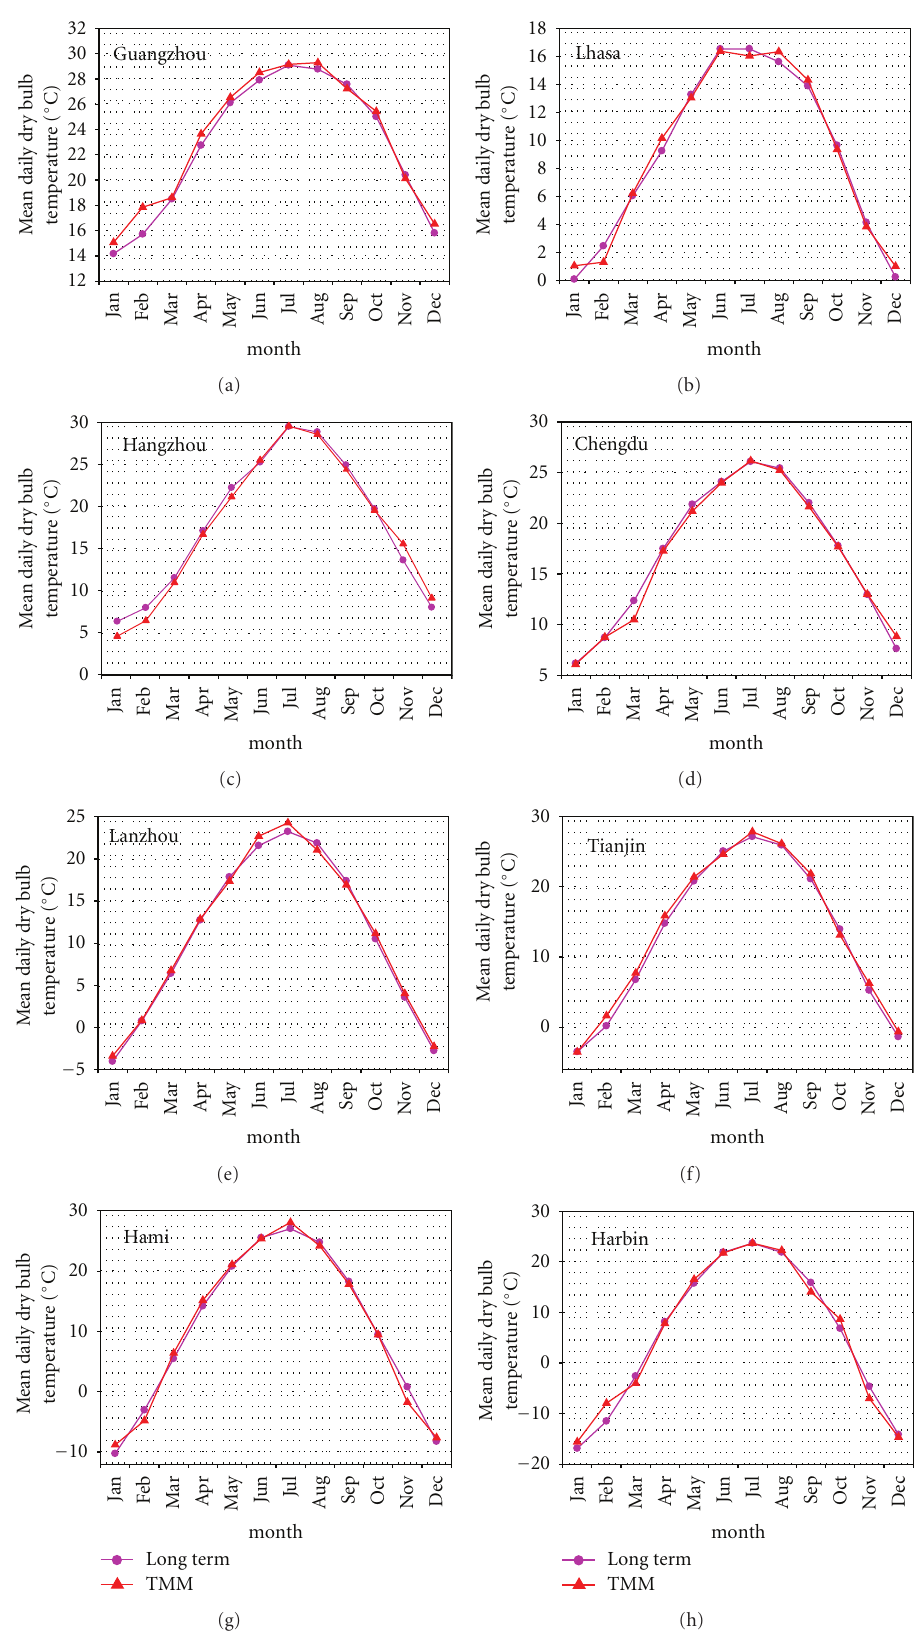
Figure 6: Monthly mean daily dry bulb temperature for the long-term and for the selected TMMs at eight